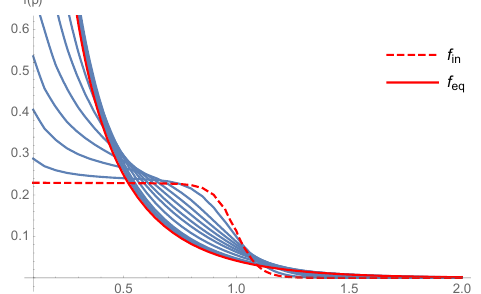
Figure 3. Evolution of the initial condition according to the Fokker-Planck scheme. The intermediate distribution functions shown are for times τ ∈ { 1,3,5,7.5,11,15.5,25.5,50,70,100 } .